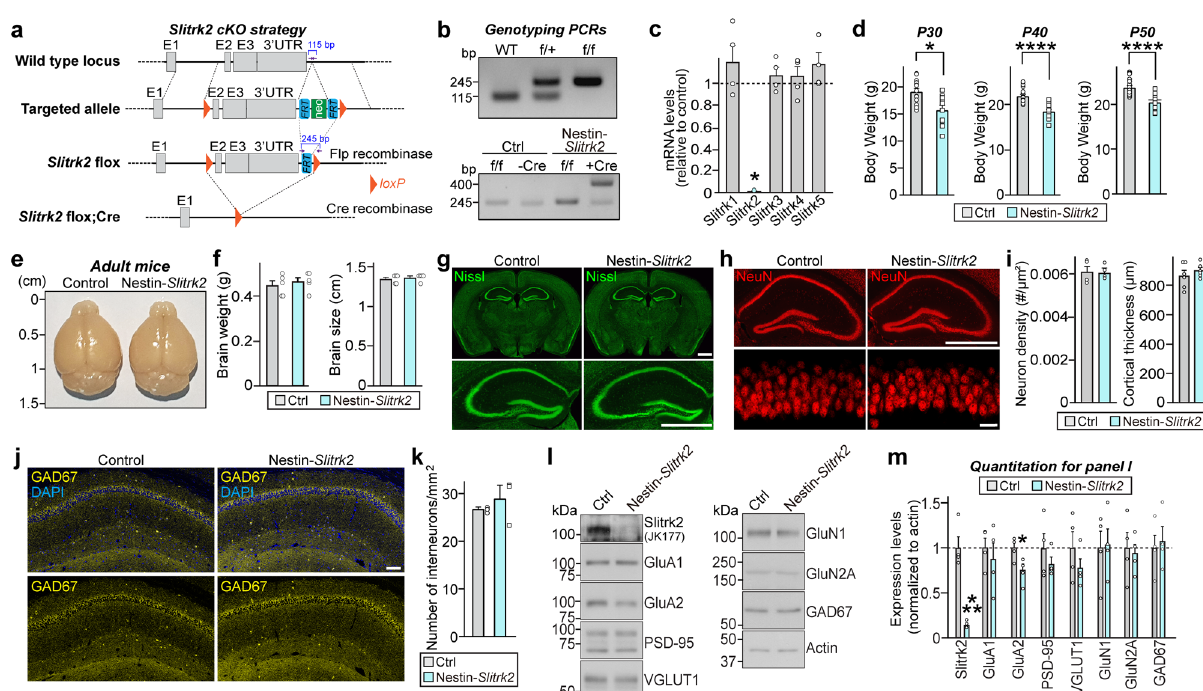
Fig. 5 Generation of Slitrk2 -cKO mice. a Strategy used to generate Slitrk2 -cKO mice. LoxP sites were introduced at positions fl anking the neomycin gene, FLP recombinant target (FRT), and exon 2 – 3 (E2 and E3) of the Slitrk2 gene. Black arrows indicate forward and reverse primers used for genotyping. Note that lacZ and neomycin cassettes are two separate markers. b PCR genotyping of Slitrk2 - fl oxed mice (top) and Nestin-Cre; Slitrk2 -cKO (Nestin- Slitrk2 ) mice (bottom). The band size for the Slitrk2 - fl oxed allele was 245 bp. The 400-bp Cre-speci fi c PCR product was detected only in Nestin- Slitrk2 mice. c Quantitative RT-PCR analyses of Slitrk mRNA levels in Nestin- Slitrk2 mice. Data are mean ± SEMs ( n = 4 mice; * p < 0.05; two-tailed Mann – Whitney U test). d Body weights of Nestin- Slitrk2 and Slitrk2 - fl oxed (Ctrl) mice at P30, P40, and P50. Data are means ± SEMs ( ‘ n ’ denotes the number of mice; P30: Ctrl, n = 15; Nestin- Slitrk2 , n = 10; P40: Ctrl, n = 20; Nestin- Slitrk2 , n = 14; P50: Ctrl, n = 20; Nestin- Slitrk2 , n = 14; * p < 0.05, **** p < 0.0001; two-tailed Mann – Whitney U test). e , f Representative photographs of whole brains ( e ) and quanti fi cation of brain weights and size ( f ) of P42 Nestin- Slitrk2 and Slitrk2 - fl oxed (Ctrl) mice. Data are means ± SEMs ( ‘ n ’ denotes the number of mice; Ctrl and Nestin- Slitrk2 , n = 5; two-tailed Mann – Whitney U test). g Normal gross morphology of the Nestin- Slitrk2 brain at 7 wks, as revealed by Nissl staining. Scale bar: 1 mm (applies to both top and bottom). h Representative images of NeuN (a neuronal marker) staining in the Nestin- Slitrk2 brain. Normal numbers of neurons in hippocampal regions. Top, hippocampus; bottom, CA1 stratum pyramidale layer. Scale bar: 1 mm (top) and 20 µ m (bottom). i Summary graphs for neuron density and cortical thickness. Data are means ± SEMs ( ‘ n ’ denotes the number of mice; neuron density: Ctrl and Nestin- Slitrk2 , n = 4; cortical thickness: Ctrl and Nestin- Slitrk2 , n = 6; two-tailed Mann – Whitney U test). j Representative images of GAD67 (GABAergic interneuron marker) staining in the hippocampal CA1 of Nestin- Slitrk2 mice. Scale bar: 0.1 mm. k Summary data for GAD67 staining from ( j ). Data are means ± SEMs ( n = 3 mice each after averaging data from 3 sections/mouse; two-tailed Mann – Whitney U test). l , m Representative immunoblots ( l ) of hippocampal lysates, and summary data showing synaptic protein levels ( m ) in crude synaptosomal fractions of P42 control and Nestin- Slitrk2 brains, analyzed by semi-quantitative immunoblotting. Data are means ± SEMs ( n = 4 mice/group; * p < 0.05, *** p < 0.001; two-tailed unpaired t-test). See Source data for raw data values and Supplementary Table 4 for statistical